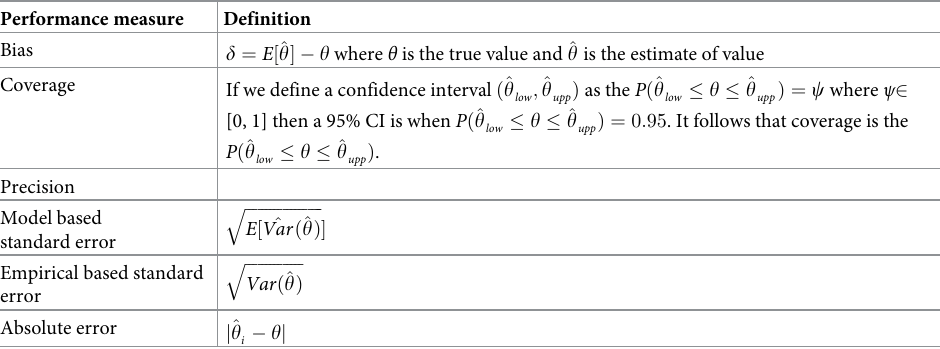
Table 2. Metrics used to measure performance in the simulation